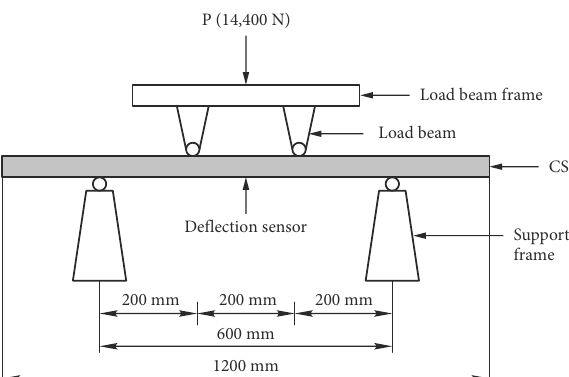
Figure 8. KS F 8006 (standard loading method for concrete form in